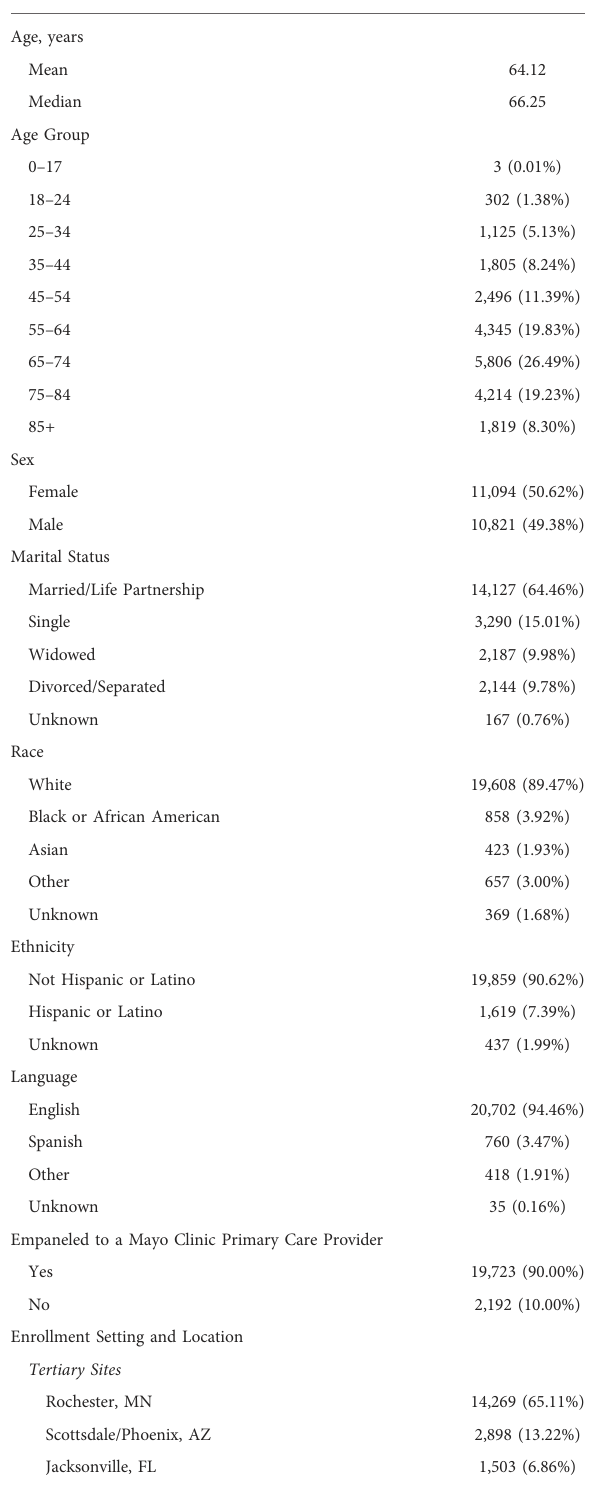
TABLE 4 Characteristics among patients monitored via RPM, from inception (2016) through September